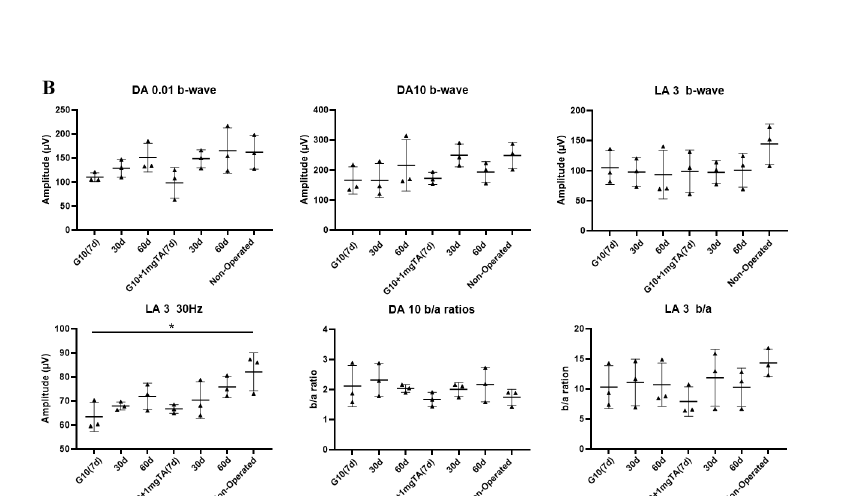
Figure 5. Functional assessment of rabbit retina by ERG. ( A ) In rabbit eyes injected with GelMA hy- drogel, there was no significant dysfunction or reduction in scotopic (DA) or photopic (LA)